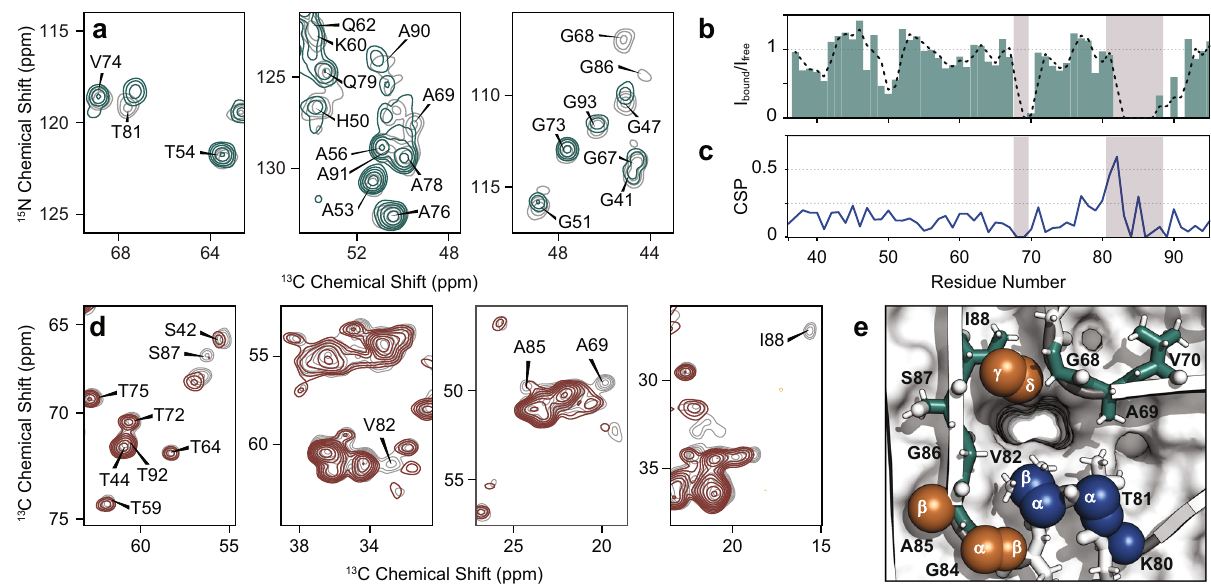
Fig.2|Chemicalshiftperturbationscomparing α -synuclein fi brilsgrowninthe presence and absence of anle138b. a Excerpts of carbon-nitrogen projections of 3D (H)CANH spectra of lipidic α -synuclein fi brils. Signal attenuation ( I bound / I free ) and chemical shift perturbation (CSP) are observed comparing spectra of fi brils with anle138b (green, 800MHz with 55kHz MAS) and without anle138b (gray, 950MHzwith 100kHz MAS). b Relative peak intensitiesfrom 3D(H)CANH spectra and c ,averageCSPfromDARRand(H)CANHspectrainducedbyanle138binside α -